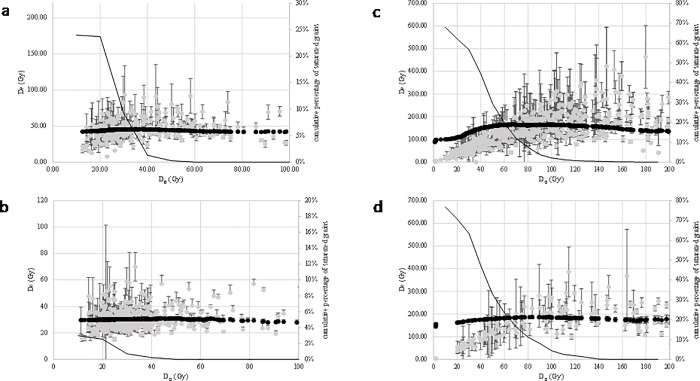
De as a function of D0 for each sample.The central De is calculated while the lowest D0 values are progressively discarded. The grey dots represent the De for each grain as a function of the D0 value of its growth curve. The black dots represent the central De while the grains with the lowest D0 values are progressively discarded. The black line represents the cumulative number of grains (in percent of the total number of grains passing the criteria) that are saturated, as a function of their minimal D0 value.